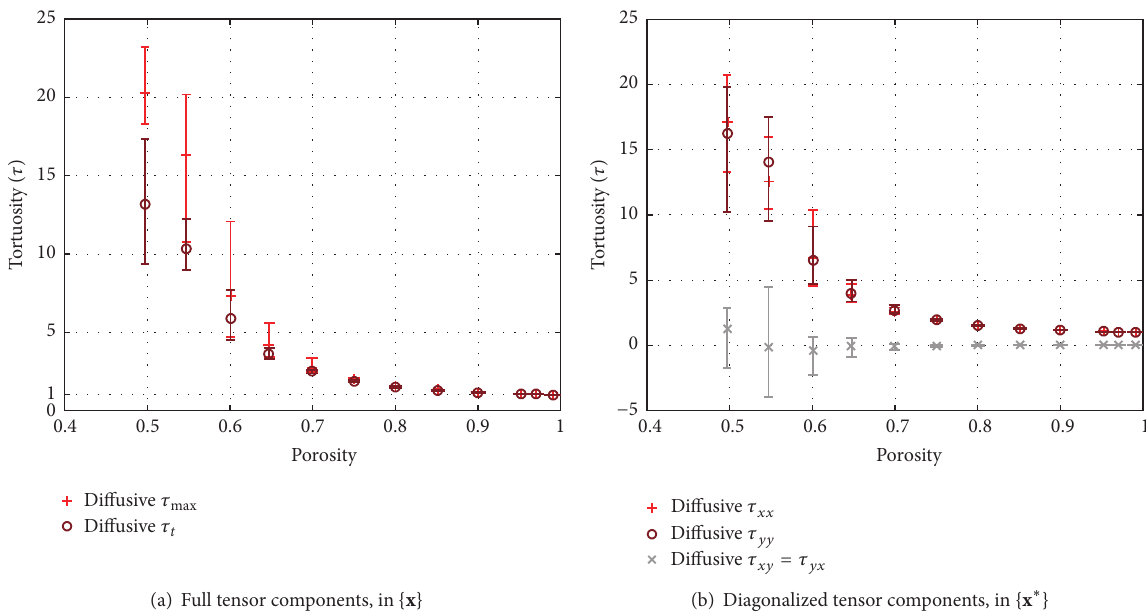
Figure 22: Diffusive tortuosity-porosity trend for randomly distributed squares. The full diffusive tortuosity tensor contains nonzero off- diagonal components and is diagonalized to obtain the principal diffusive tortuosity components, 𝜏 𝑑, max and 𝜏 𝑑,𝑡 . { x } and { x ∗ } are related by rotation angle 𝜃 𝑑 , which is plotted in Figure 16(a). The anisotropic ratio of the principal components is plotted in Figure 16(b).